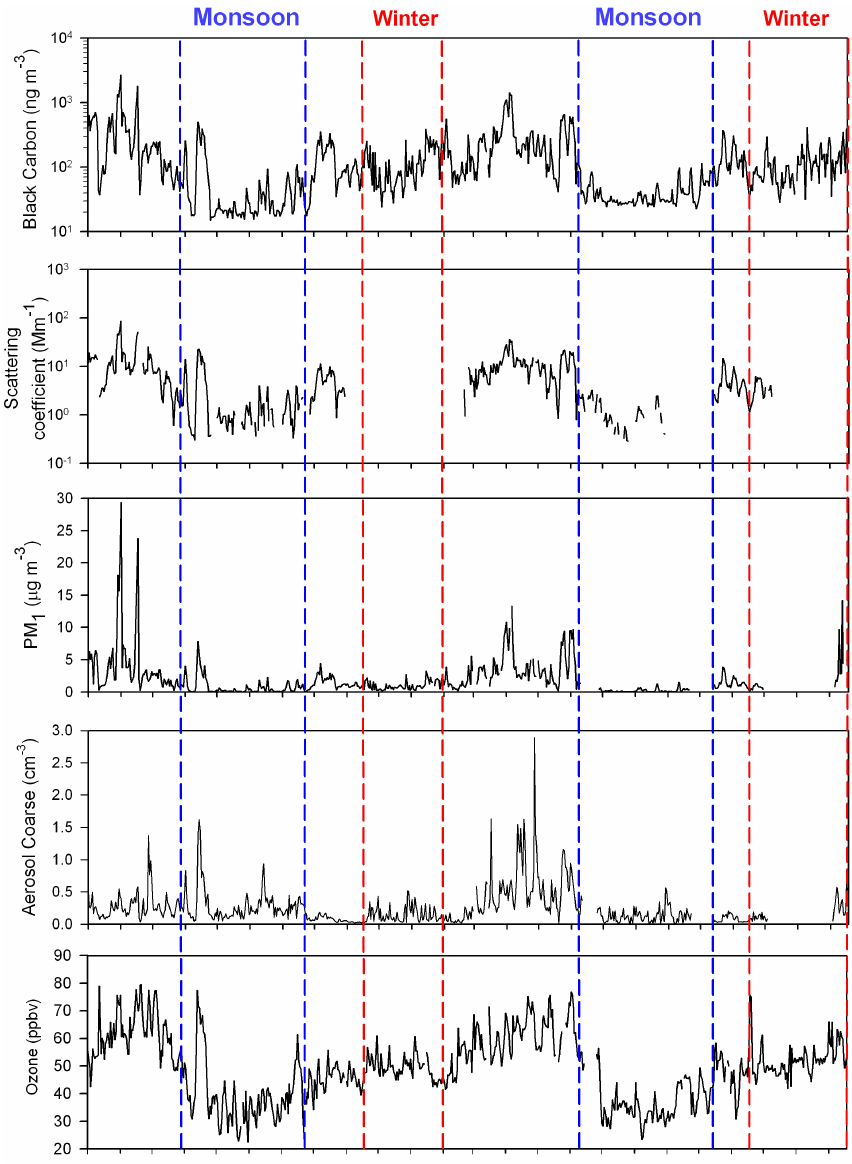
Fig. 7. Seasonal time series (daily averages) of BC, aerosol scattering coefficient, PM 1 , coarse particle number and surface O 3 at NCO-P from March 2006 to February 2008. Seasons (as defined in Table 1) are also reported: red – winter; light blue – monsoon. BC is reported by log-scale on